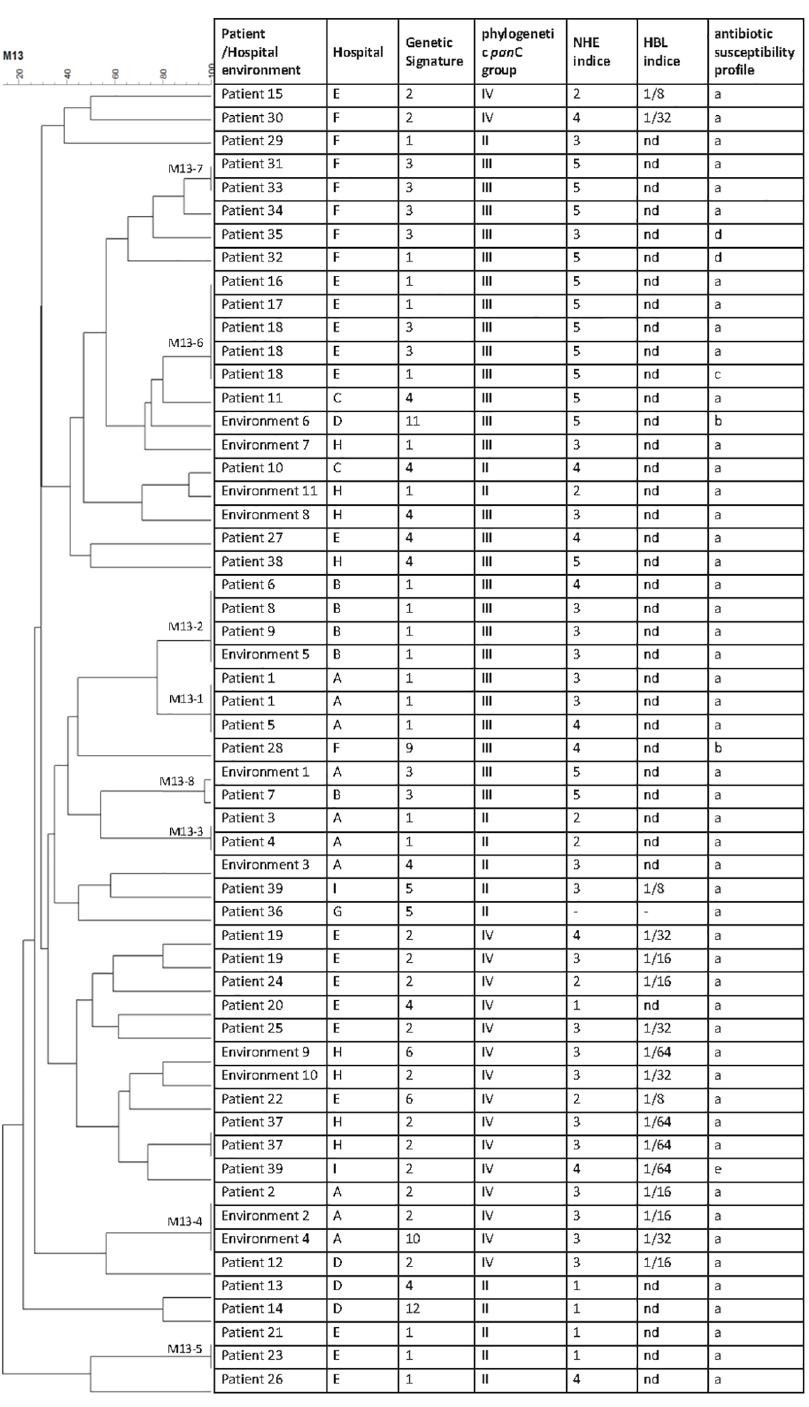
Fig 1. Dendogram and strain data. Left panel, dendrogram obtained by cluster analysis of M13-PCR fingerprint patterns of the 56 strains. The UPGMA was used to build a dendrogram from a pair wise similarity matrix. Seven clusters were obtained with strains sharing 100% of homology. Right panel, data include for each strain the corresponding patient and hospital, genetic signature, phylogenetic pan C group, NHE and HBL indice, and the antibiotic susceptibility profile. nd: not